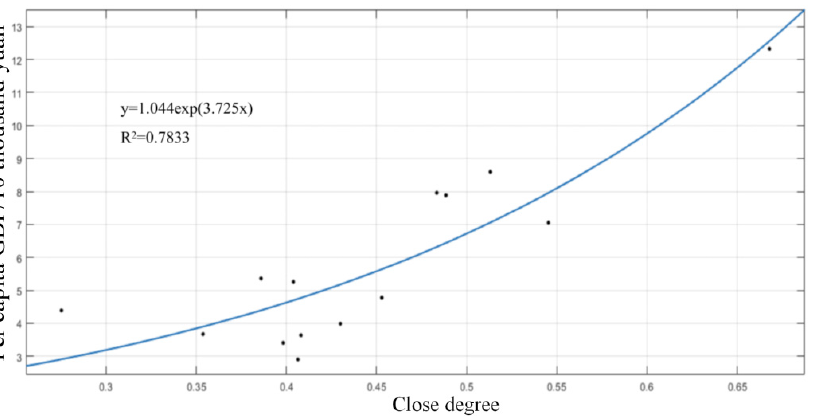
Figure 8. Relationship between per capita GDP and closer degree of grassroots water services in Hunan Province.